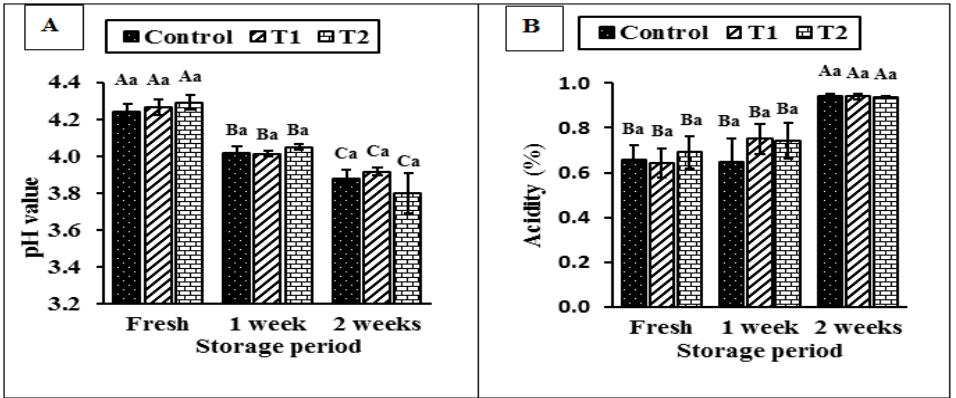
Figure 4. Effect of different concentrations of CrPi on the pH of the media during yoghurt fermentation. Control: without Cr (CrPi), T1: with 0.25 ppm Cr (CrPi), T2: fortified with 0.5 ppm Cr (CrPi). The data are shown as mean ± SE for three replicates.